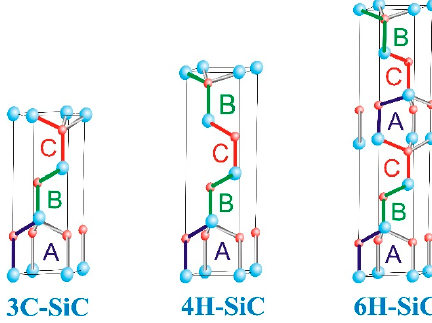
Figure 11. Stacking sequence of SiC polytypes.